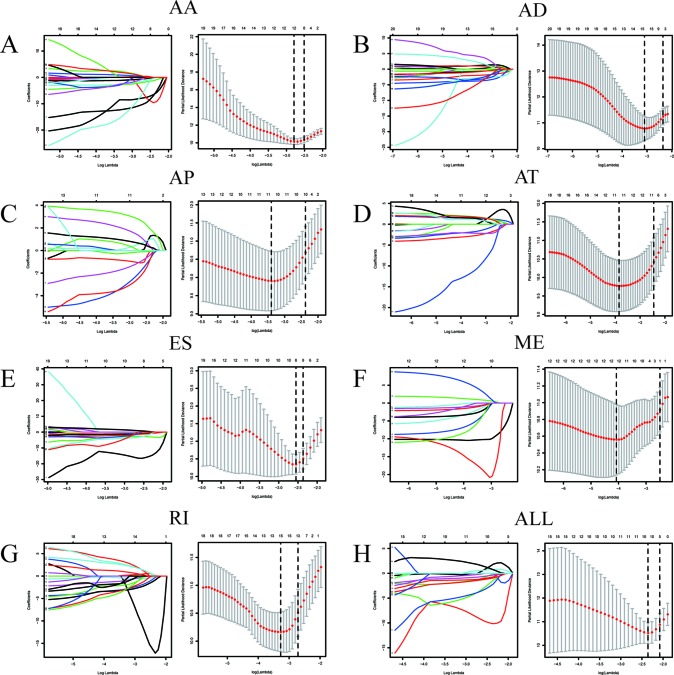
LASSO Cox analysis of alternative splicing (AS) events. LASSO Cox regression model with 10‐fold cross‐validation was constructed using the top significant survival‐associated AS events to screen the key AS features in AA (A), AD (B), AP (C), AT (D), ES (E), ME (F), RI (G) and all AS events (H).